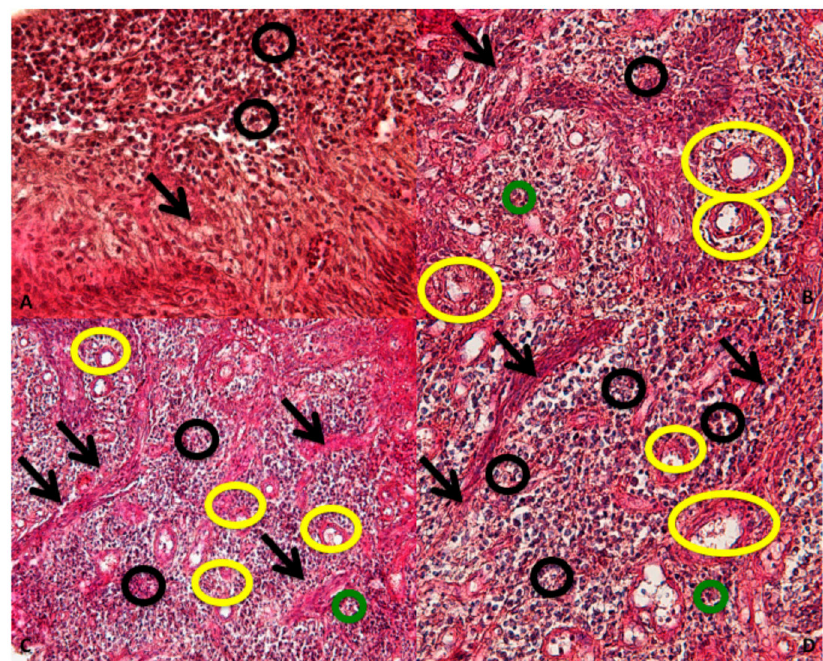
Figure 6. ICT organization: collagen fibers (black arrows); vascular structure (yellow circles); inflammatory cells (black and green circles). (Magnification 40 × ).